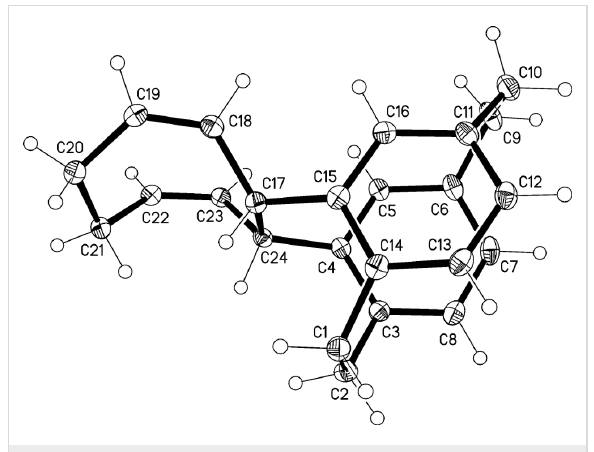
Figure 2: The molecule of compound 15 in the crystal. Ellipsoids correspond to 30% probability levels.